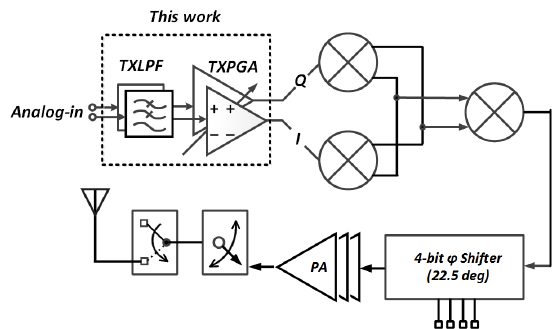
Figure 1. Transmitter block diagram.